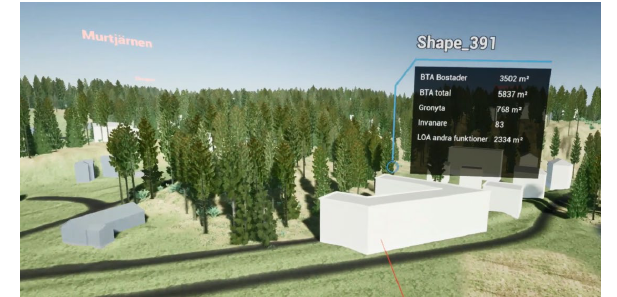
Figure 4 . Buildings with information about size and use